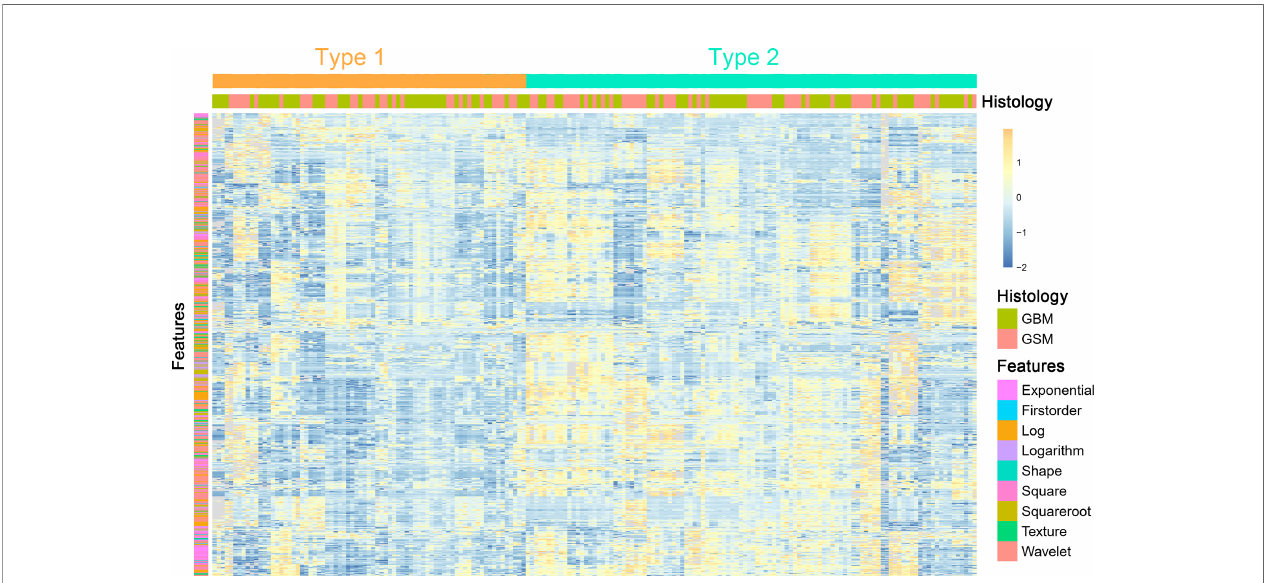
FIGURE 2 | A heat map shows the stable radiomic features. Each column and row correspond to one patient and z-score normalized radiomic feature, respectively.